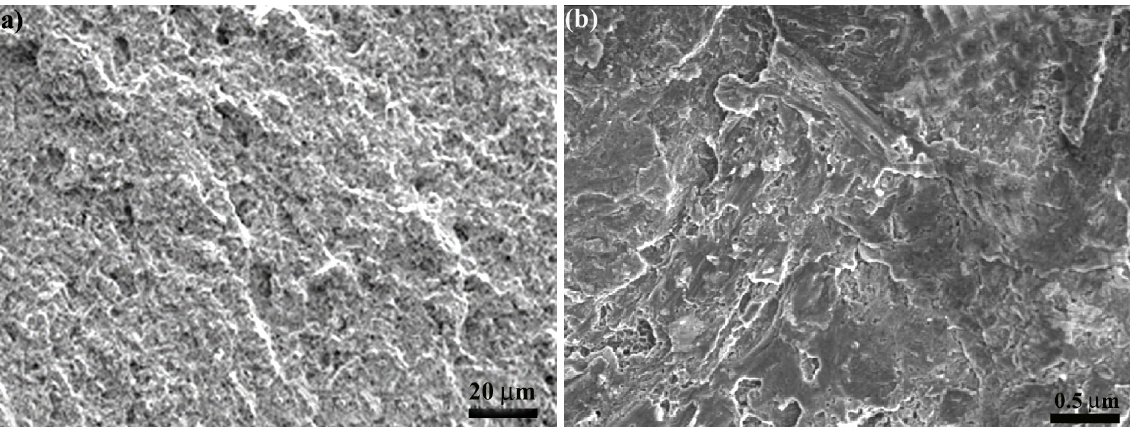
Figure 9. Microstructure of the dissimilar joint interface.